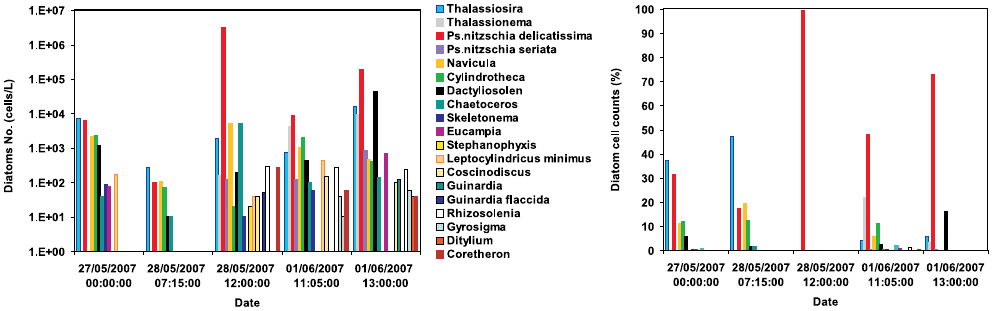
Fig. 4. Total and normalized cell counts for the diatom population in the oceanic seawater samples collected during the RHaMBLe cruise (color legend is in the same order as plot bars). The analysis identified Ps.nitzschia delicatissima and Thalassiosira as the dominant diatom species in the seawater samples.